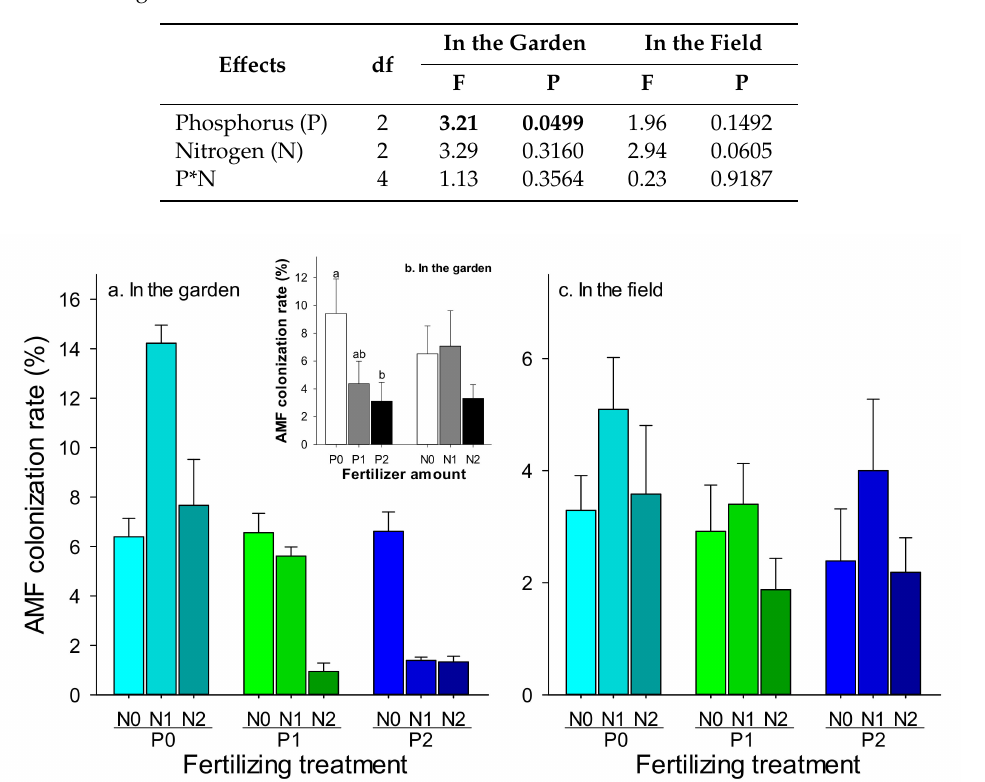
Table 2. The dependence of the arbuscular mycorrhizal fungi (AMF) colonization rate on the amounts of phosphorus (P0, P1, P2) and nitrogen (N0, N1, N2) fertilization and their interaction in the garden and the field. Significant results are indicated in bold.